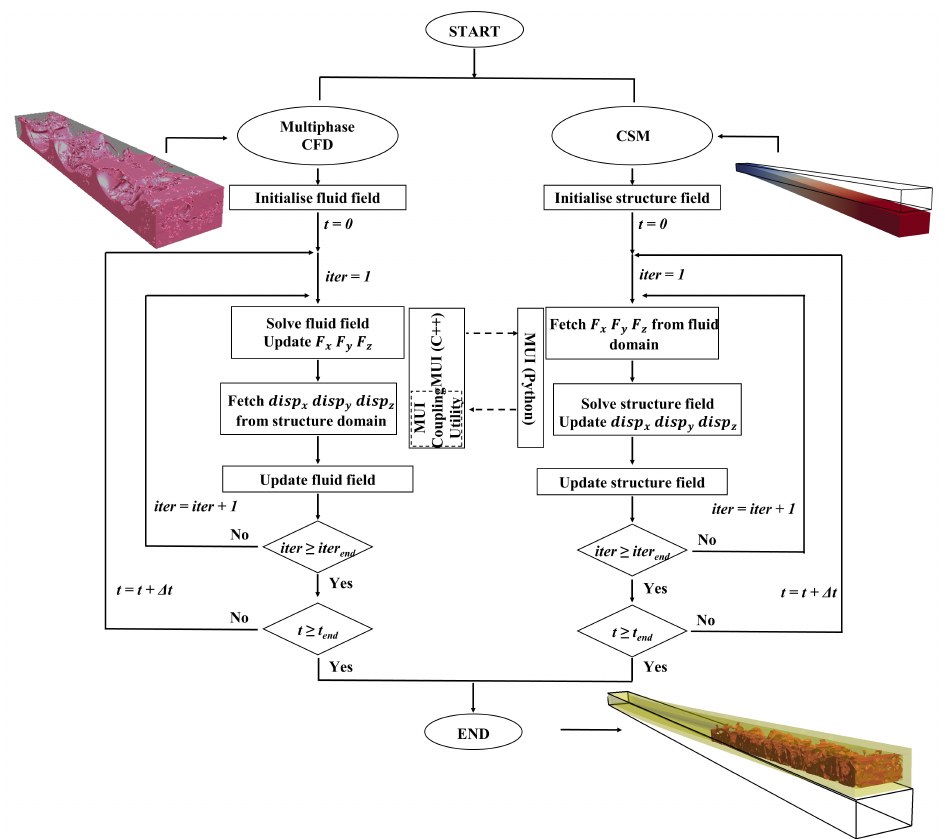
Figure 2. Schematic of the open-source framework, ParaSiF , with the two-way implicit FSI cou- pling